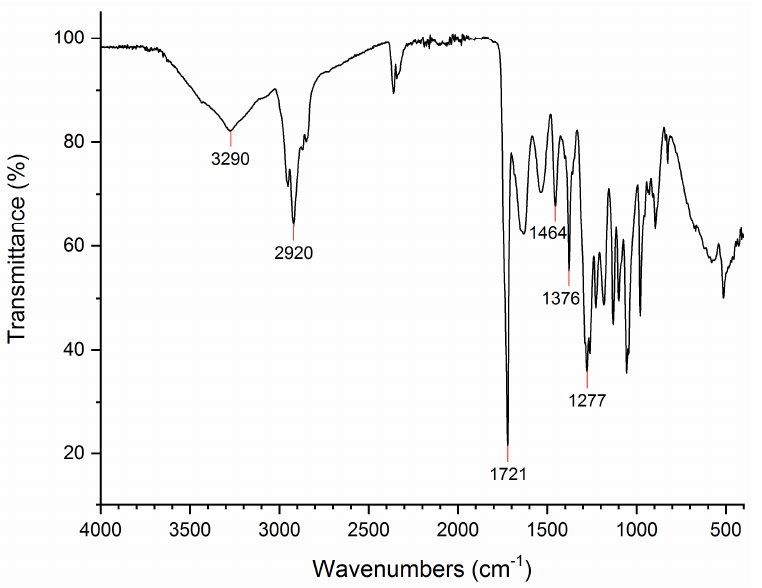
Figure 5. FTIR spectrum of isolated PHB produced by Pseudomonas sp. phDV1 grown in M9 minimal media supplemented with 600 mg/L phenol as the sole carbon source. The characteristic peaks associated with infrared-active functional groups of PHB are indicated by the red lines.